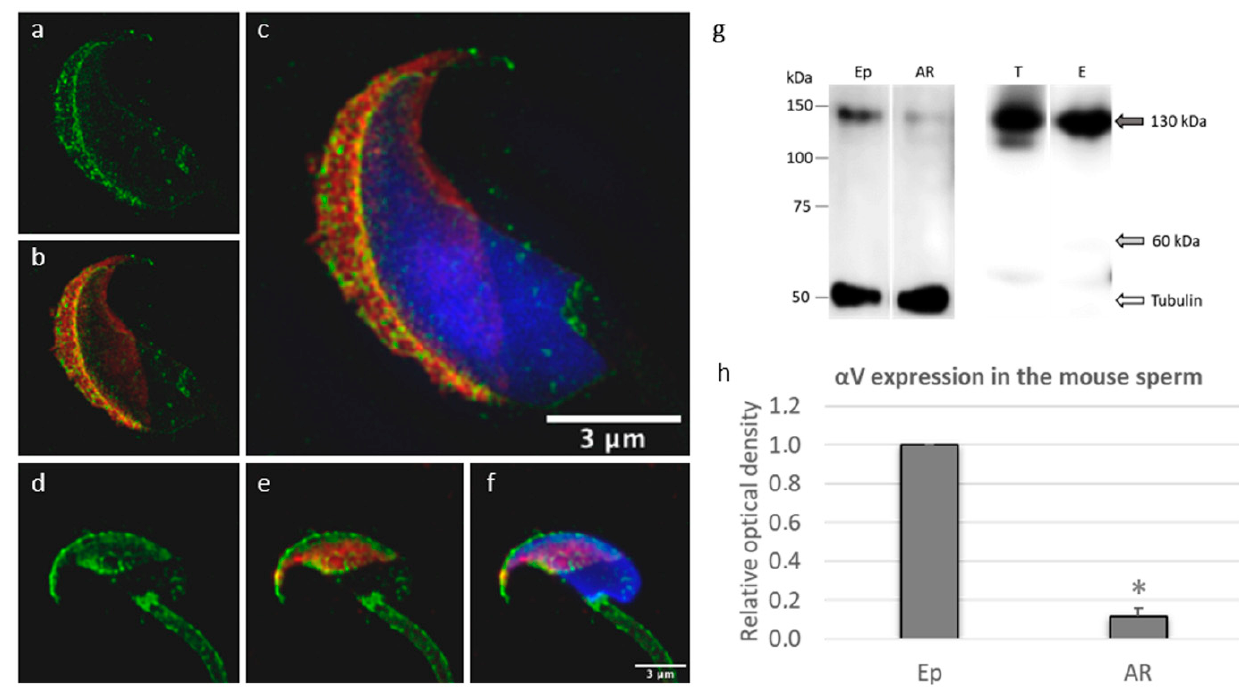
Figure 3. Detection of α V integrin in mouse spermatozoa and reproductive tissues. ( a – c ) The α V integrin (green) localization on the intact sperm head was visualized by SIM and confined to the PM defining the acrosomal region, extending to the apical hook region with a light signal over the post-acrosomal region and neck. Both OAM and IAM were detectable. ( d–f ) The α V integrin (green) localization after the acrosome reaction was captured by confocal microscopy and depicted strongly in IAM covering the equatorial segment including the PM extending to the post-acrosomal region enriched in the neck and tail. The PM of the apical hook region remained strongly labeled. Acrosomal status was visualized by PNA staining (red); Hoechst (blue) was used for detection of the nucleus. Scale bars represent 3 µM. ( g ) Western blot immunodetection of α V integrin in the extracts from epididymal sperm (Ep), acrosome-reacted sperm (AR), testis (T), and epididymis (E). Anti α V integrin antibody detected bands with a molecular weight of 130 kDa (gray arrow). ( h ) Western blot densitometry analysis in protein extracts normalized to the amount of tubulin shows a decreased expression of α V integrin ( p < 0.05; *) in acrosome-reacted (AR) sperm in comparison with epididymal (Ep) sperm.